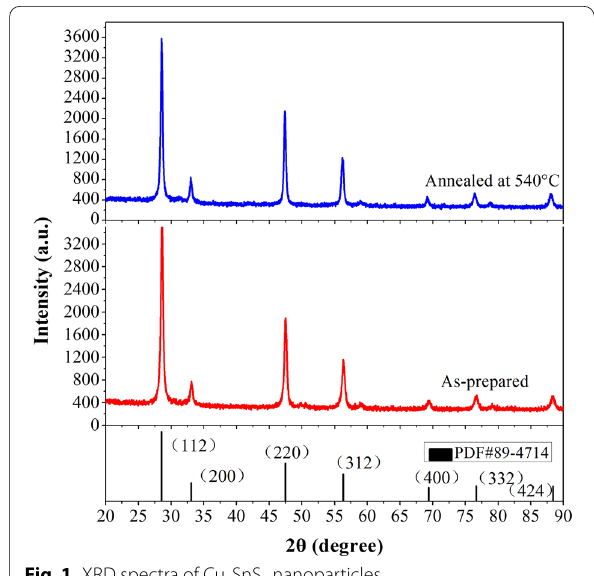
Fig. 1 XRD spectra of Cu 2 SnS 3 nanoparticles